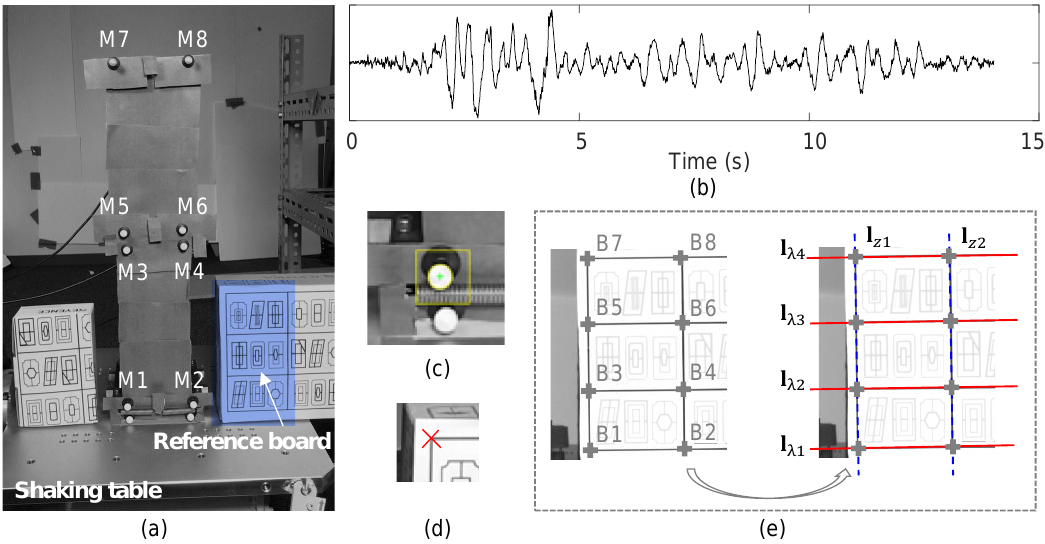
Figure 12. Experiment test setup: ( a ) overview of the two-story base-isolated structure with artificial tracking markers, ( b ) scaled earthquake ground motion acceleration record, ( c ) circular-based tracker, ( d ) correlation-based tracker, ( e ) reference board and lines extracted for projective